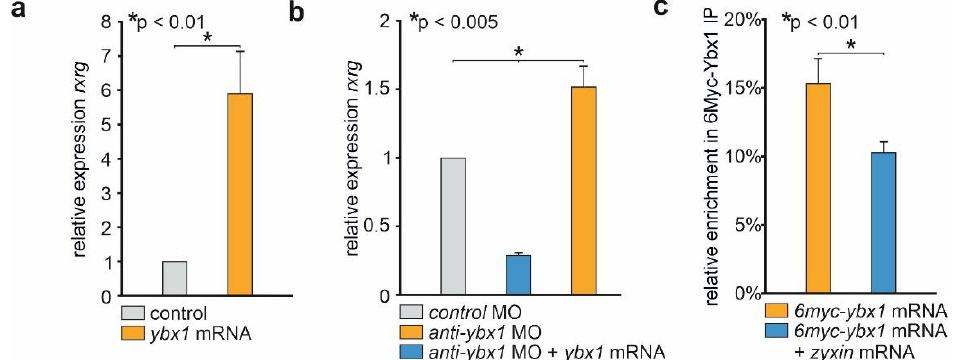
Figure 2. Zyxin regulates the stability of rxrγ mRNA by preventing formation of the Ybx1/mRNA complex. ( a ) Overexpression of ybx1 leads to an increase in the rxrγ mRNA level. ( b ) Suppression of ybx1 mRNA translation by anti-ybx1 MO decreases the rxrγ mRNA level, while co-expression of ybx1 mRNA restores it, even with some overshooting. ( c ) RIP experiments demonstrate the ability of Ybx1 to bind rxrγ mRNA, whereas Zyxin reduces this ability. Error bars indicate standard deviation. p -value was measured by Student’s t-test. The data presented are averaged from at least three independent experiments.